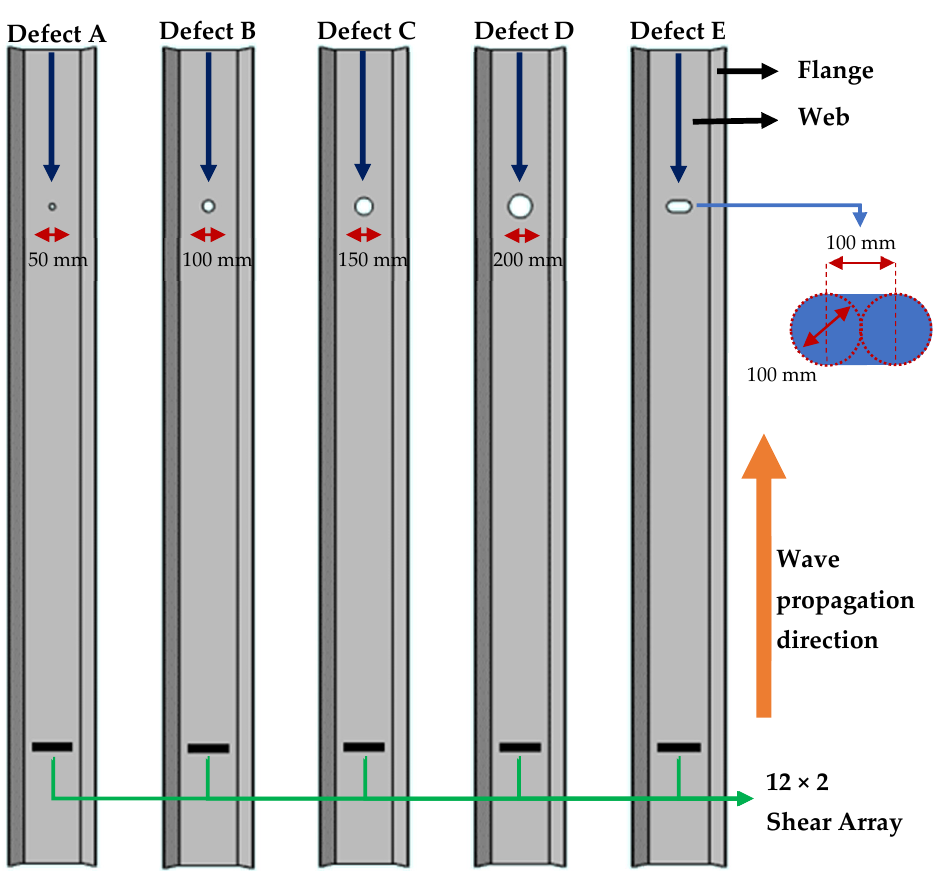
Figure 9. Defect scenarios using 50 mm, 100 mm, 150 mm, 200 mm diameter defects and a slot defect were considered .